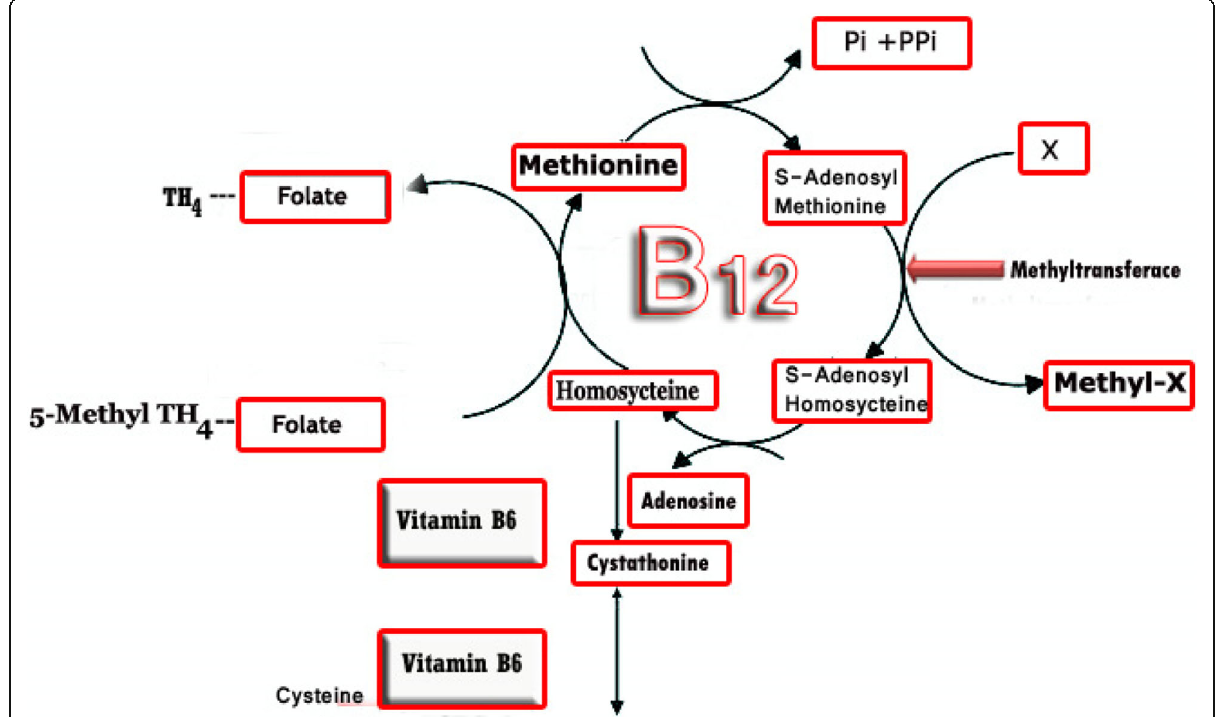
Fig. 2 Metabolic pathway of vitamin B 12 in human body (modified from Selladurai et al.